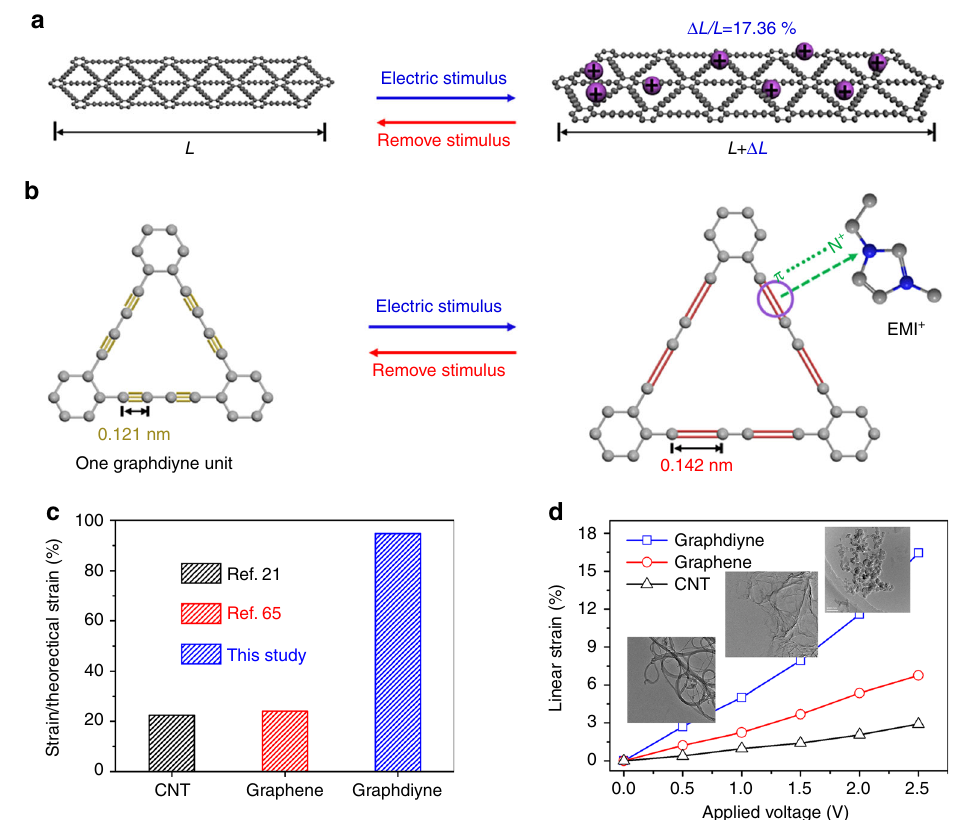
Fig. 4 Actuation mechanism of graphdiyne materials. a Schematic for actuation strain of graphdiyne when encountering electric stimulus. b Alkene – alkyne complex transition mechanism in one graphdiyne unit. c Linear strain of graphdiyne, graphene, and carbon nanotube fi lms under various applied voltages by SECM method. Inset shows TEM images of the three materials. d Strain retention of theoretical value of the three